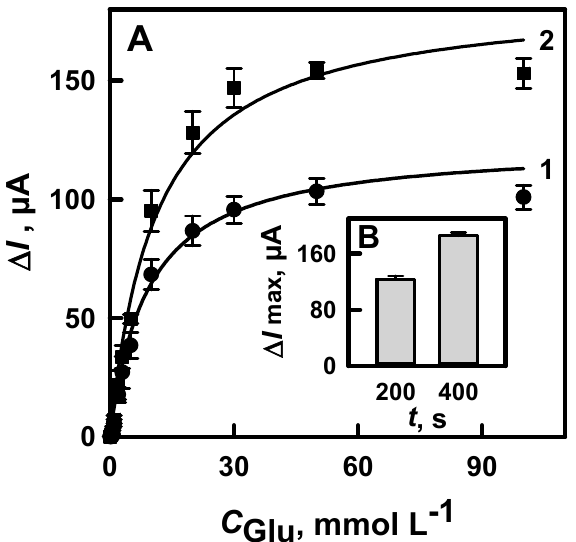
Figure 3 . Calibration plots ( A ) and diagrams ( B ) of glucose biosensors based on DGNs electrochemically deposited for different periods of time. Electrochemical deposition of DGNs was performed in a solution of 6 mmol L − 1 HAuCl 4 with 0.1 mol L − 1 KNO 3 at constant − 0.2 V potential for 200 s (curve 1) and 400 s (curve 2).